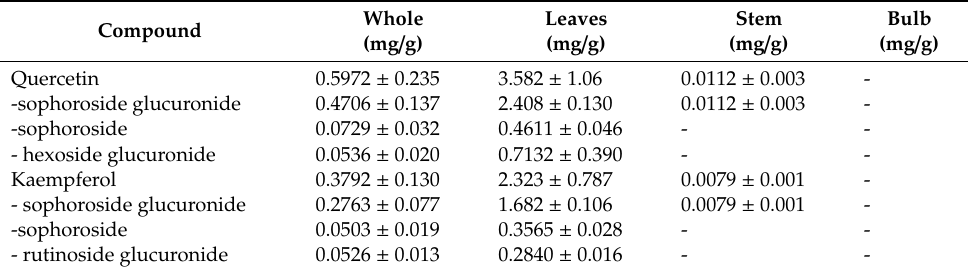
Table 2. Estimated quantities of the the major identified flavonol glycosides in whole ramps and parts using ultra-high-performance liquid chromatography (UHPLC)-photodiode array (PDA) detection.